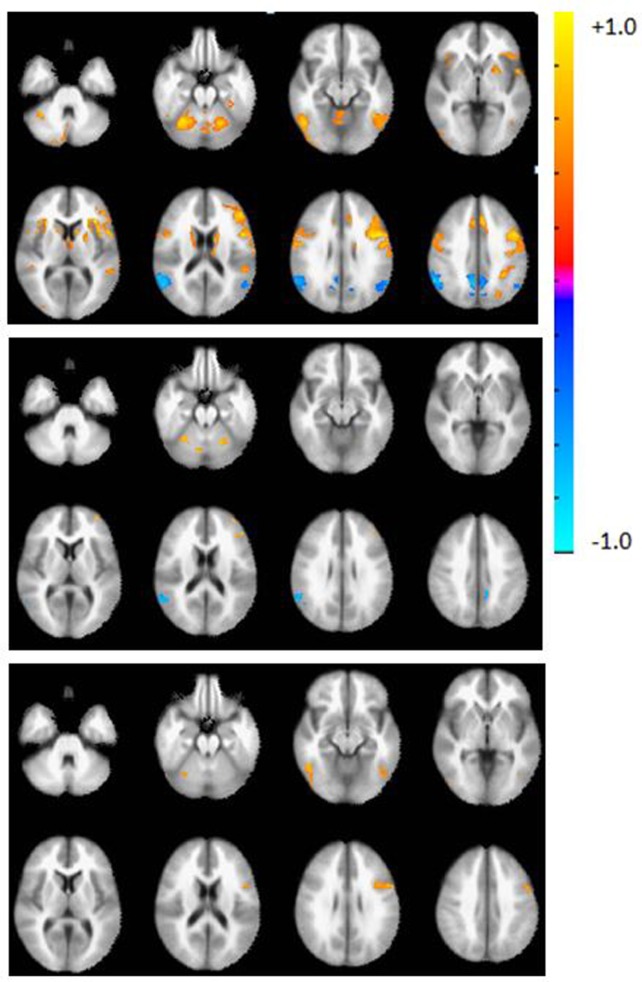
Axial view of the group activation maps before calibration during the verbal fluency task in controls (top), patients (middle), and difference map (controls > patients, bottom panel). Maps are in radiological convention, left = right, p < 0.05, corrected using AFNI’s 3dClustSim. Warm colors indicate areas of activation with respect to the rest block; cool colors indicate deactivation with respect to the rest block.